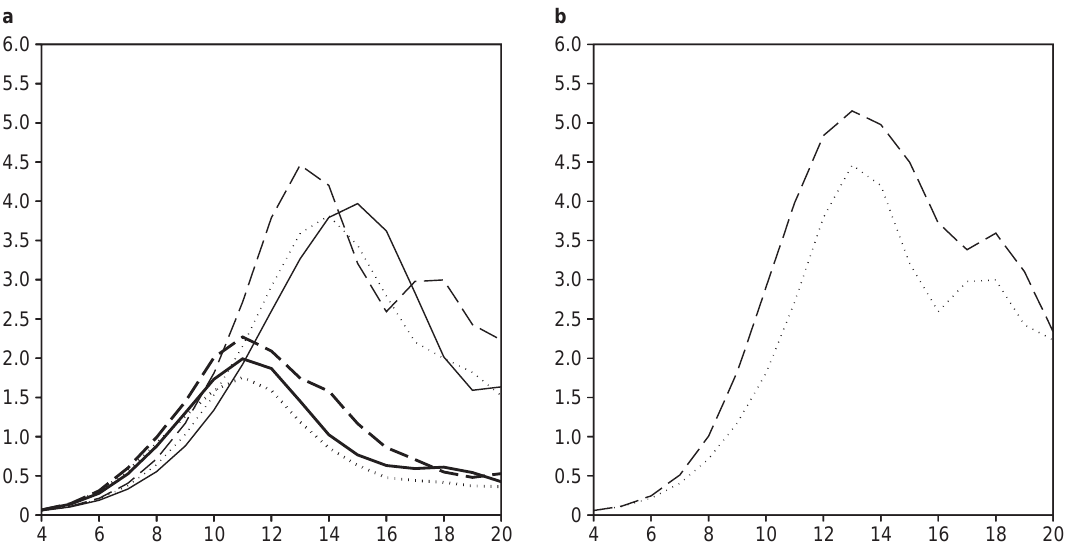
Fig. 10. a Time development of eddy kinetic energy, K e as in Fig. 3, for 6 life cycles. Heavy curves have just the large-scale rain parametrization. Light curves have boundary layer drag added. Solid curves are DRY, dotted curves G100ST60, dashed curves G100. b As a